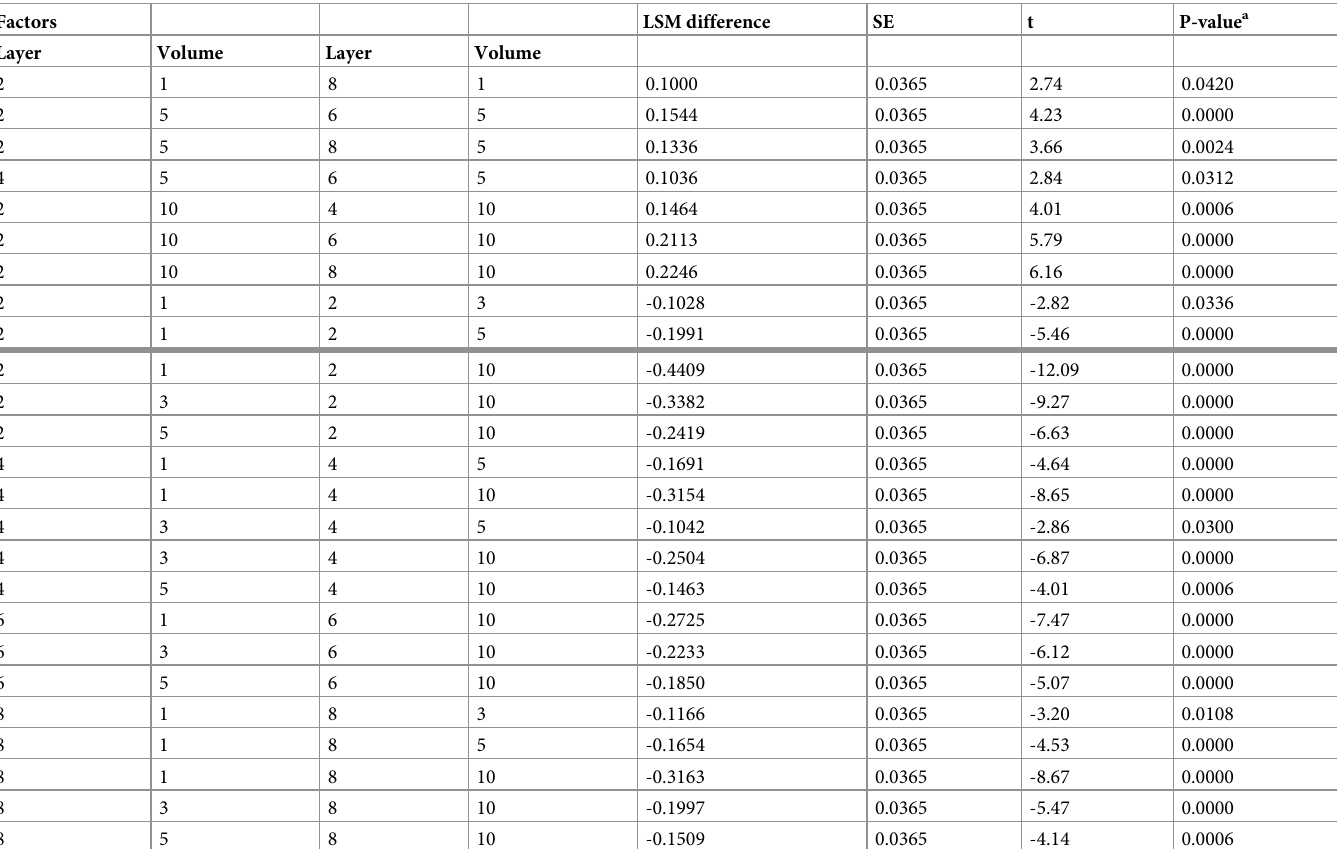
Table 1. Statistically significant comparisons in post hoc analysis comparing the effect of layers and volume on area